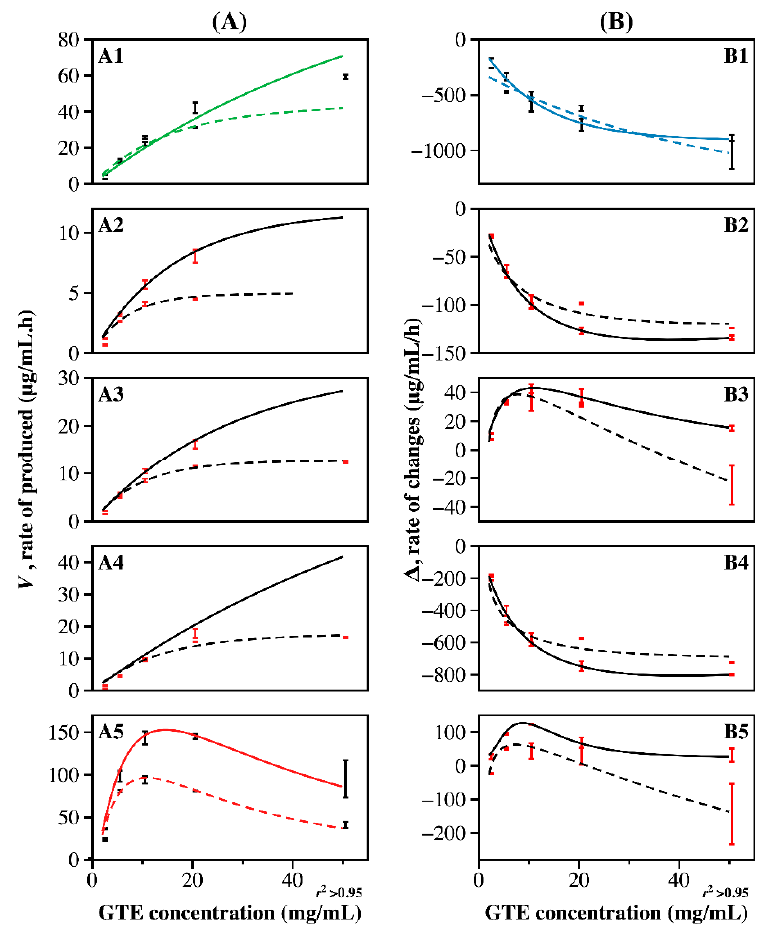
Figure 5. Effects of substrate concentration for producing flavonol aglycones and gallic acid (GA) in enzymatic reactions. ( A1 ) sum of flavonols, ( A2 ) kaempferol, ( A3 ) quercetin, ( A4 ) myricetin, ( A5 ) GA, ( B1 ) sum of catechins, ( B2 ) ECG, ( B3 ) EC, ( B4 ) EGCG, ( B5 ) EGC. Lines indicate: dotted line, 35 ° C; solid line, 50 ° C. All graphs were applied fitted regression curves ( r 2 > 0.95) from an equation of JMP12 (SAS Institute Inc., Cary, NC, USA).